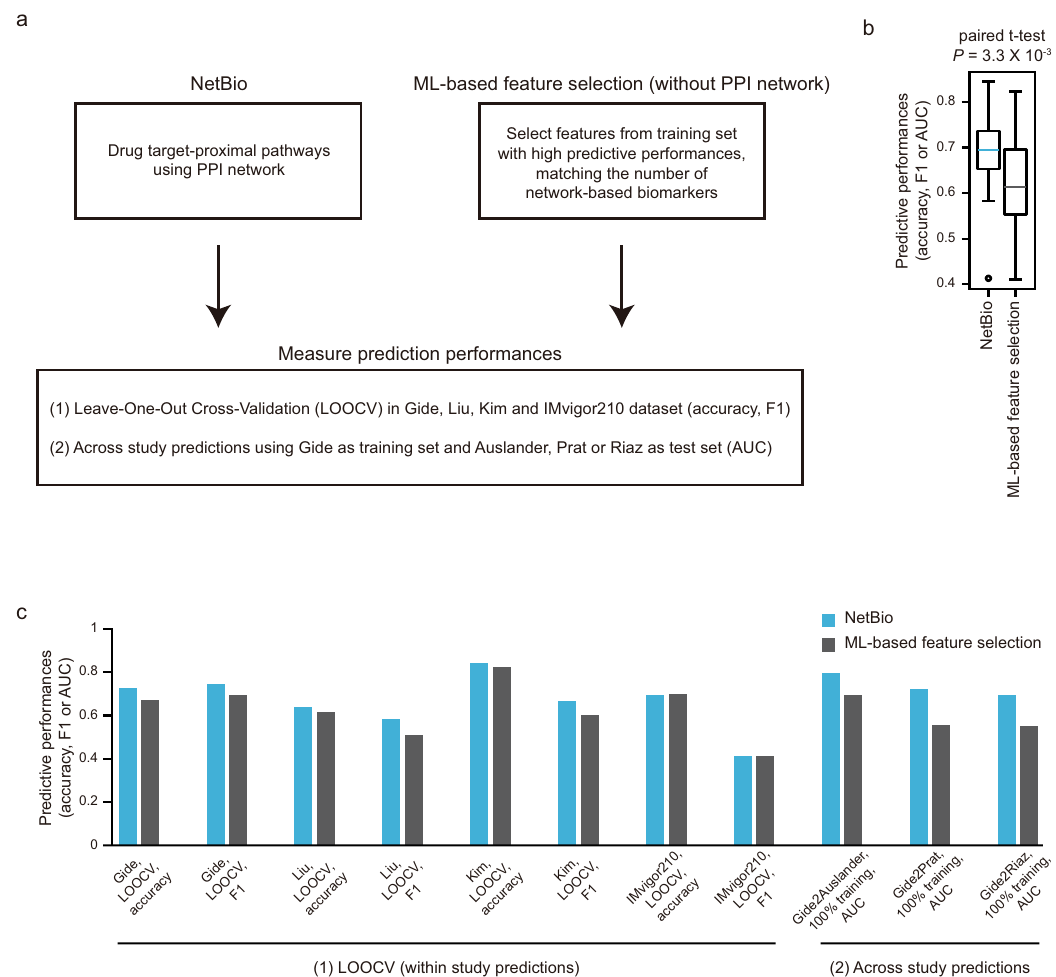
Fig. 4 Comparison of predictive performance using machine learning-based feature selection. a Overall scheme for comparisons. b Overall predictive performance using NetBio-based or machine learning-based feature selection for 11 independent tests. Statistical signi fi cance was measured using the two- sided paired-sample t test. Boxplot shows median value, interquartile range (IQR) as bounds of the box and whiskers that extends from the box to upper/ lower quartile ± IQR × 1.5. c Bar plots of predictive performances in 11 different tests, using accuracy, F1 score, or AUC as a metric to quantify performance. Source data are provided as a Source Data fi